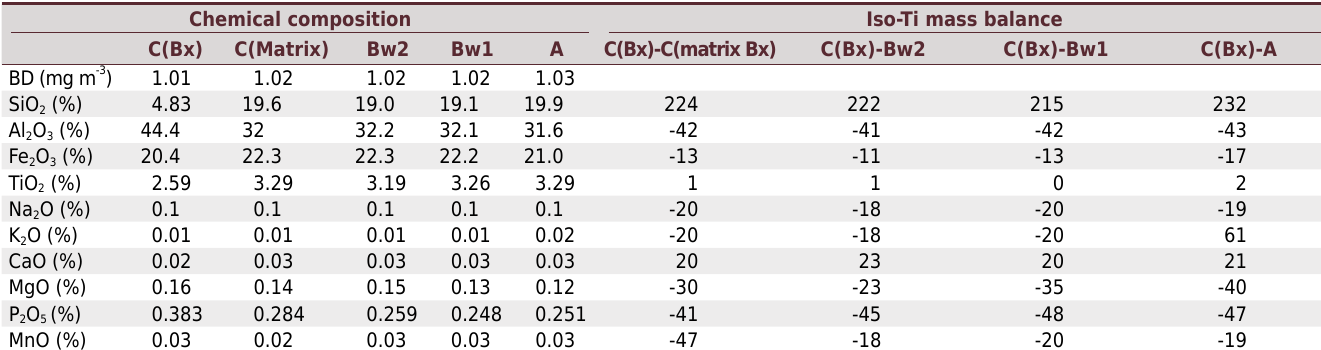
Table 2. Chemical composition and isoelement titanium (Iso-Ti) mass balance of Ferralsol 2 profile Chemical